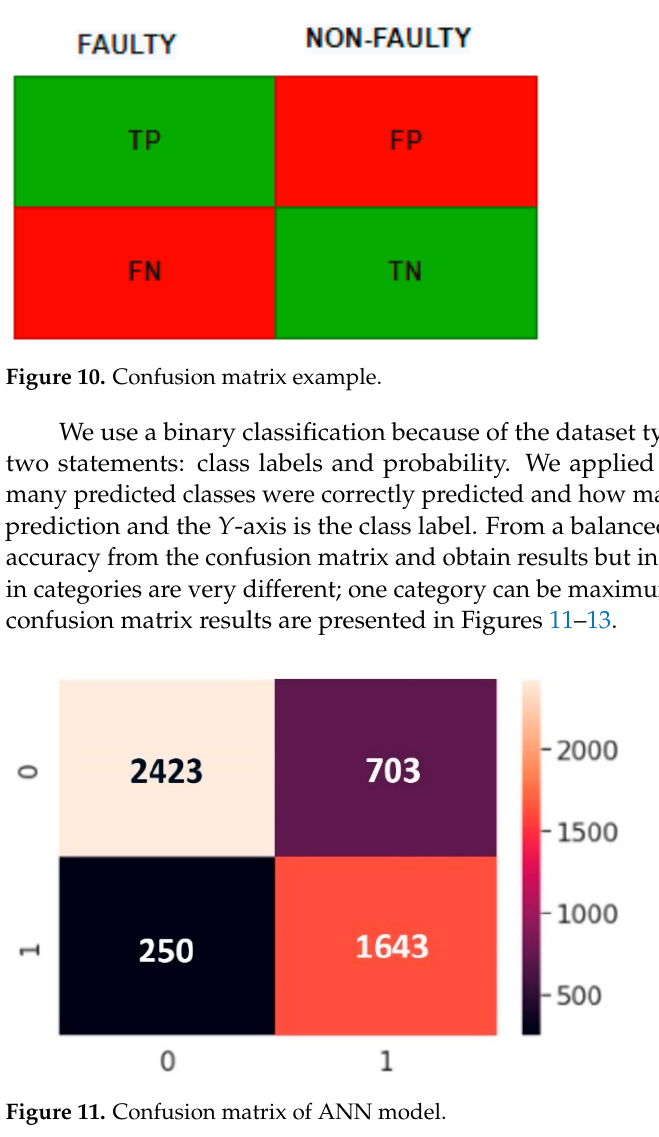
Figure 11. Confusion matrix of ANN model.